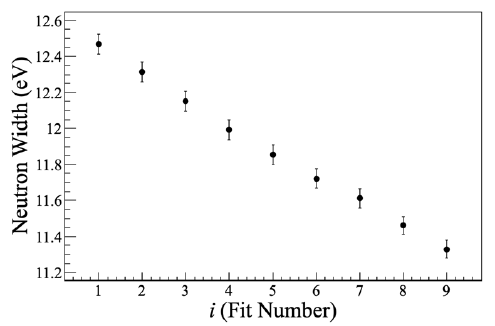
Figure 8. Neutron width of resonance No. 4 for each sample